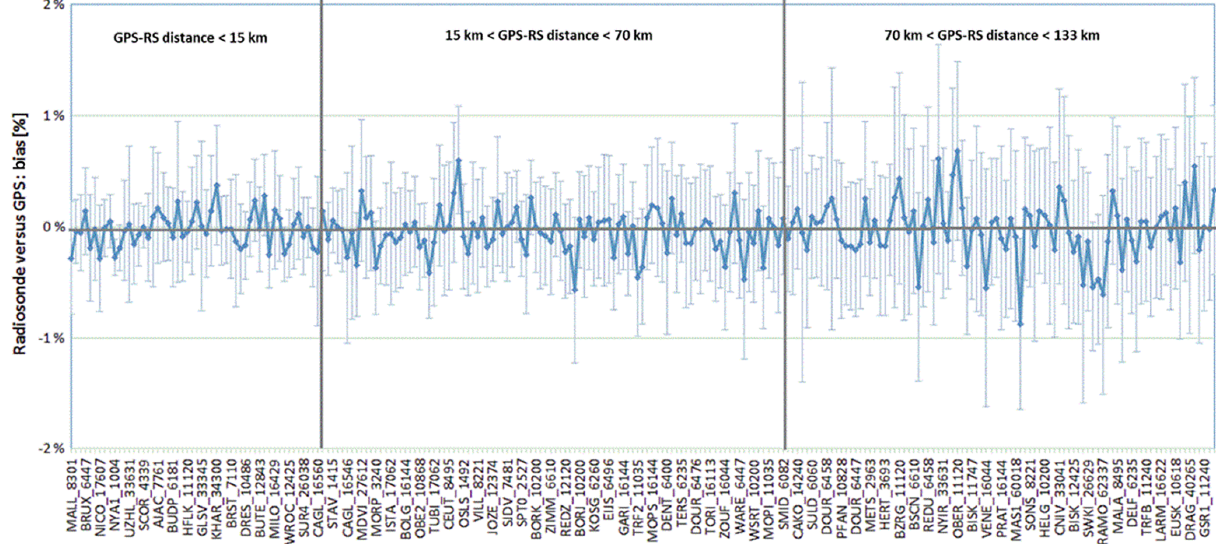
Figure 10. RS minus GNSS ZTD biases for all GNSS-RS station pairs. The error bar is the standard deviation. Sites are sorted with increasing distances from the nearest radiosonde launch